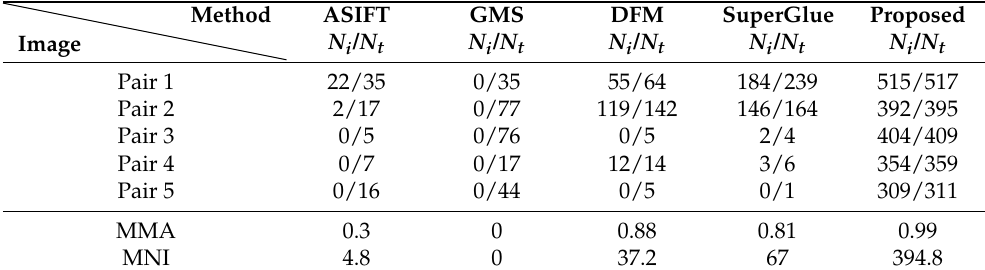
Table 2. Quantitative results of the different methods on dataset Dort-ZECHE. Image